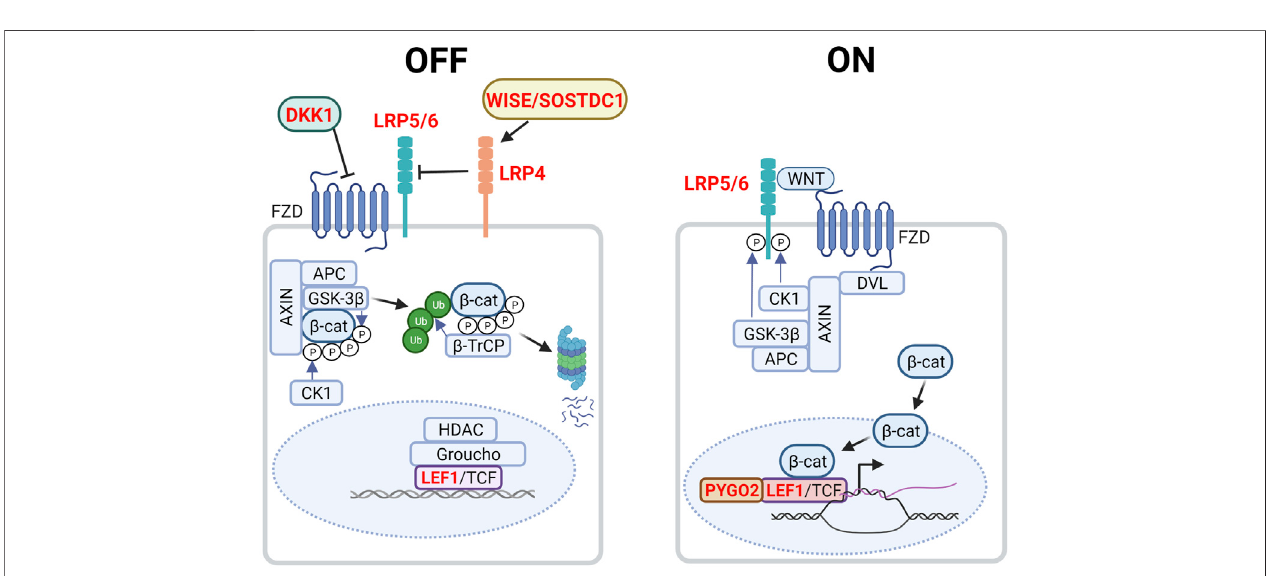
FIGURE2| Canonical WNT/ β -catenin signaling in theembryonic mammary gland. IntheabsenceofWNT(left,OFFstate),cytoplasmic β -catenin istargeted tothe destruction complex comprising AXIN, APC, GSK3 β and CK1 where it is phosphorylated. Phosphorylated β -catenin is ubiquitinated by the E3 ubiquitin ligase β -TrCP, which targets β -catenin for proteasomal degradation. WNT target genes are repressed by Groucho and histone deacetylases (HDACs). LRP4 and its potential ligand, WISE/SOSTDC1 inhibits WNT signaling. In the presence ofWNT ligand (right, ON state), areceptor complex forms between FZD and LRP5/6. DVL recruitment by FZDleadstoLRP5/6phosphorylationandAXINrecruitment.Consequently,degradationof β -cateninisdisrupted,allowing β -catenintoaccumulateinthenucleuswhere it functions as a co-activator of LEF1/TCF to promote the transcription of target genes. Genes highlighted in red denote those that give rise to aberrant embryonic mammary gland phenotypes when deleted or overexpressed. P denotes phosphorylation events after overexpressed. Figure created with BioRender.